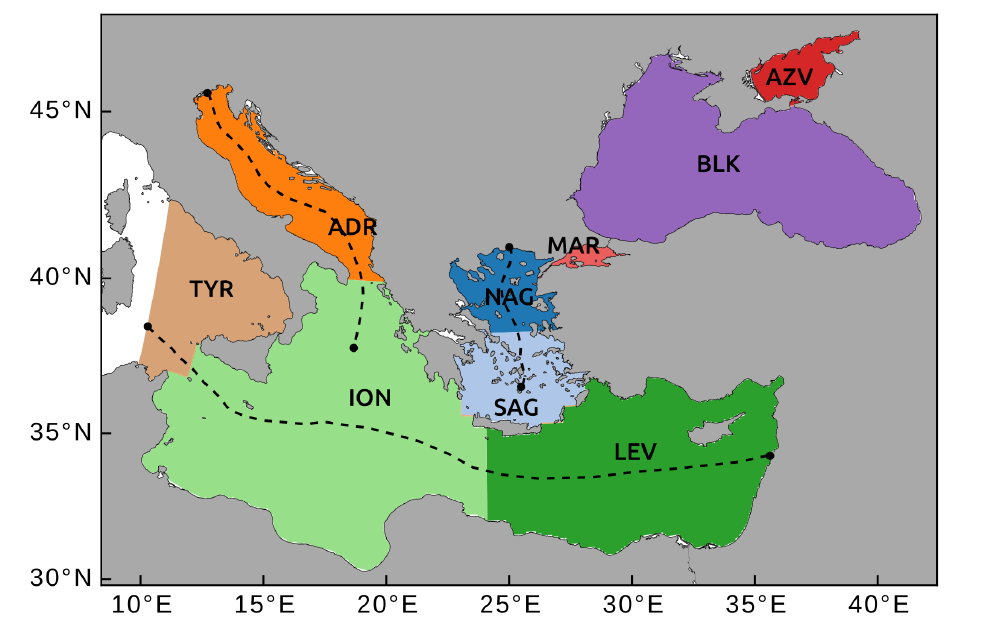
Figure 1. Spatial coverage of the individual sub-basins in the Eastern Mediterranean–Black Sea system, as defined within this study. Azov Sea (AZV), Black Sea (BLK), Marmara Sea (MAR), Aegean Sea (comprised by North Aegean, NAG and South Aegean, SAG), Levantine Sea (LEV), Ionian Sea (ION), Adriatic Sea (ADR), and Tyrrhenian Sea (TYR). Dashed lines indicate the mid-sections upon which potential density is